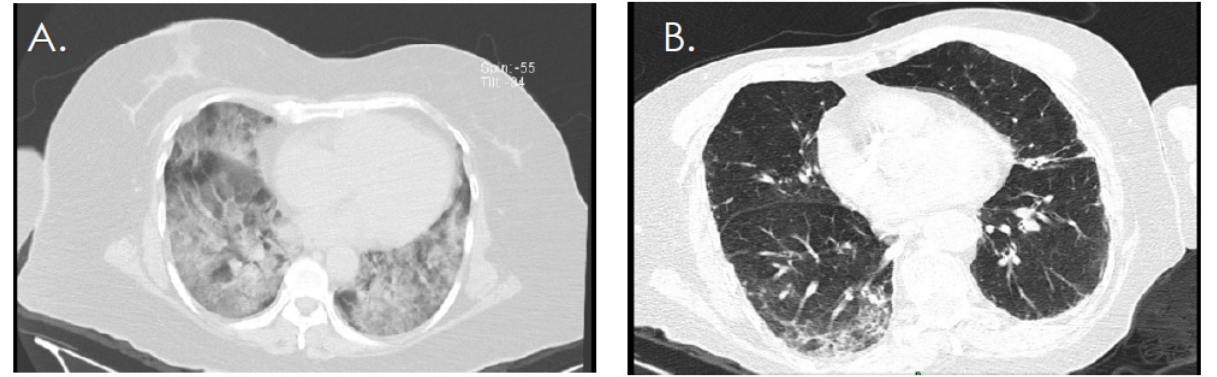
Figure 1. Representative chest-computed axial tomography (CT) slices. Each patient was screened based on anatomical abnormalities observed on chest CT scans. ( A ) Chest CT findings categorized as CO-RADS 5 and ( B ) chest CT findings classified as CO-RADS 3. CO-RADS, COVID-19 Reporting and Data System.